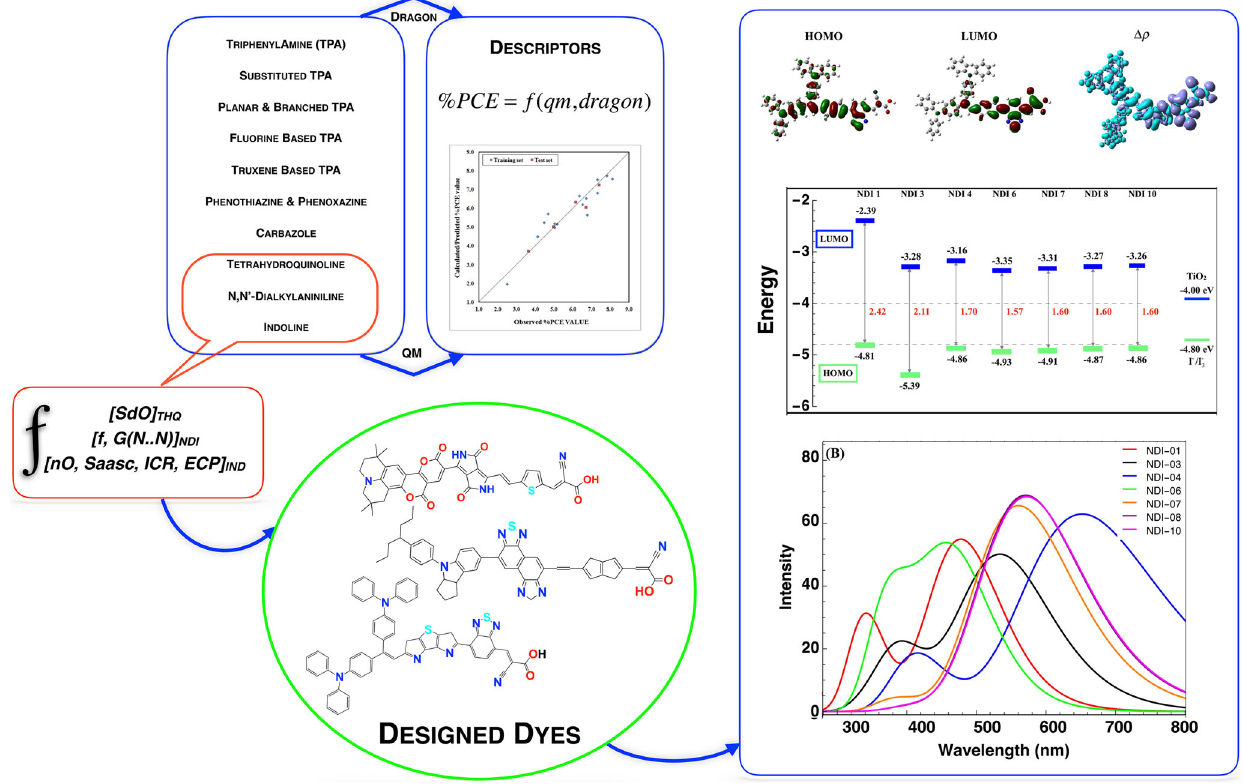
Fig. 4 Schematic representation of the complete work fl ow from modeling to design to prediction to quantum study and their